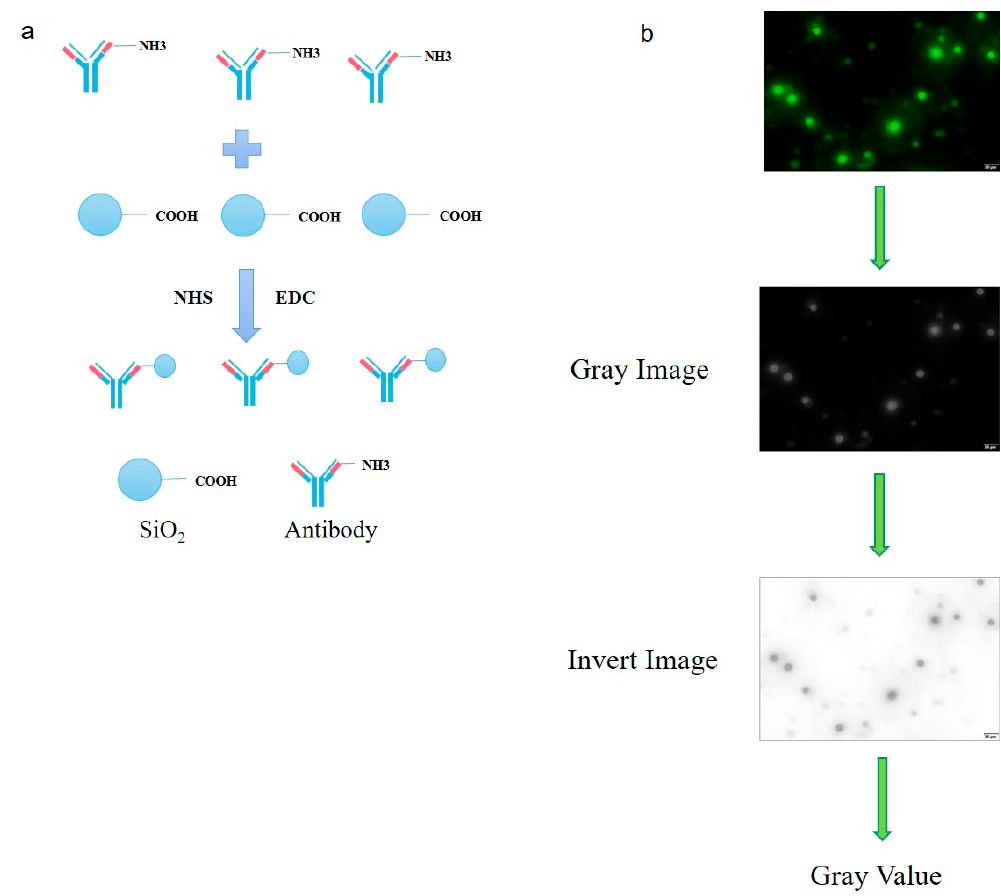
Figure 5. Coupling of silica microspheres and antibodies and gray value analysis of fluorescence Images. ( a ) Principle of coupling between silica microspheres and antibodies: under the catalysis of NHS (N-Hydroxysuccinimide) and EDC (1-(3-Dimethylaminopropyl)-3-ethylcarbodiimide hydro), selecting the carboxyl modified silica microspheres is covalently bound to the amino group of the serum antibody prepared by us. ( b ) Fluorescence intensity analysis of fluorescence images: Image J software used to analyze the gray value of fluorescence images. Scale bar = 50 µ m.